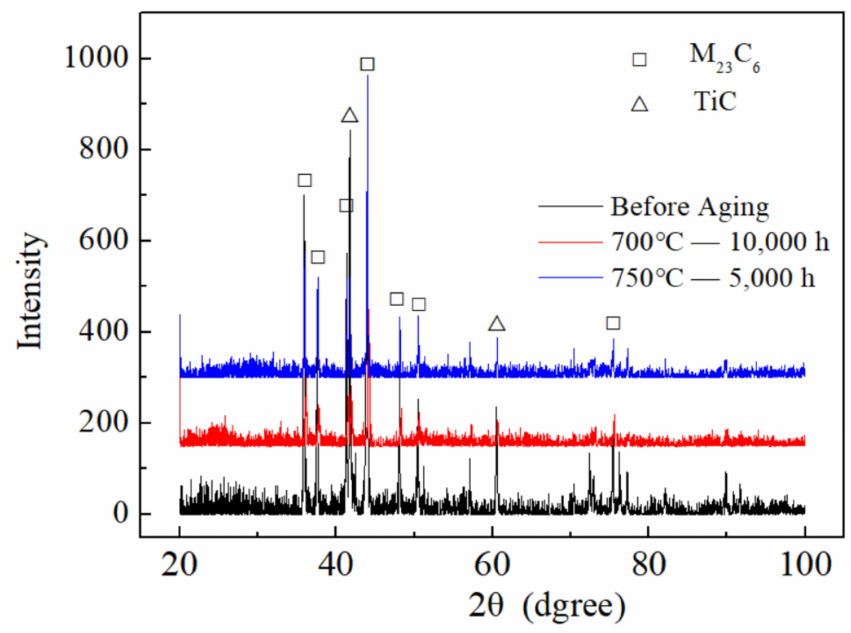
Figure 3. XRD patterns of carbides precipitated in the new alloy before and after long-term aging at different